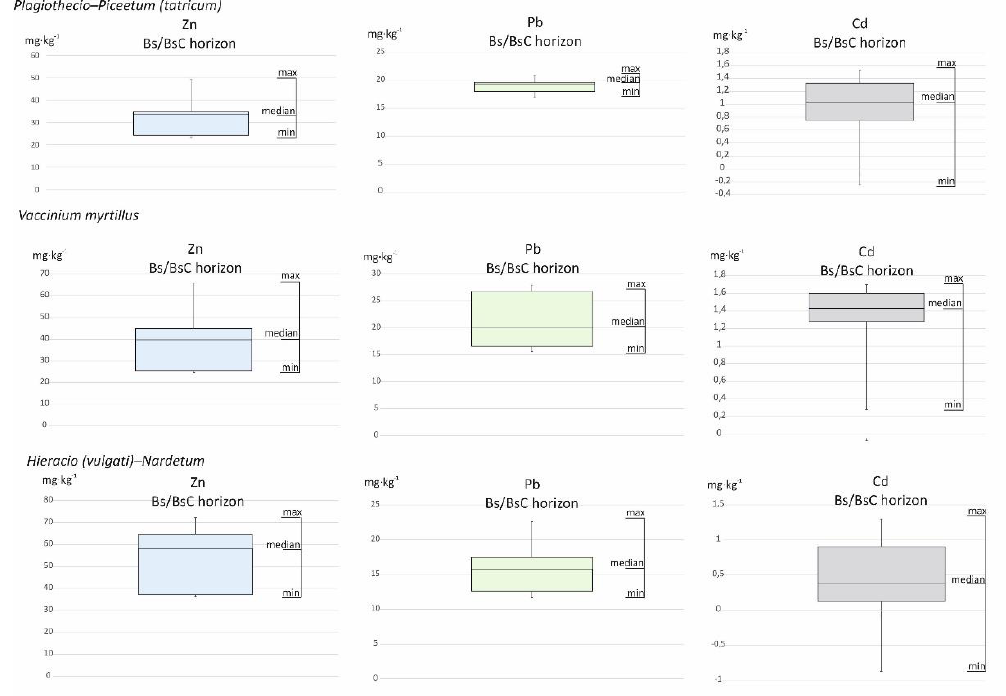
Figure 6. Whisker plots diagram on Zn, Pb, and Cd content in Bs or BsC horizon in soils under various vegetation types.